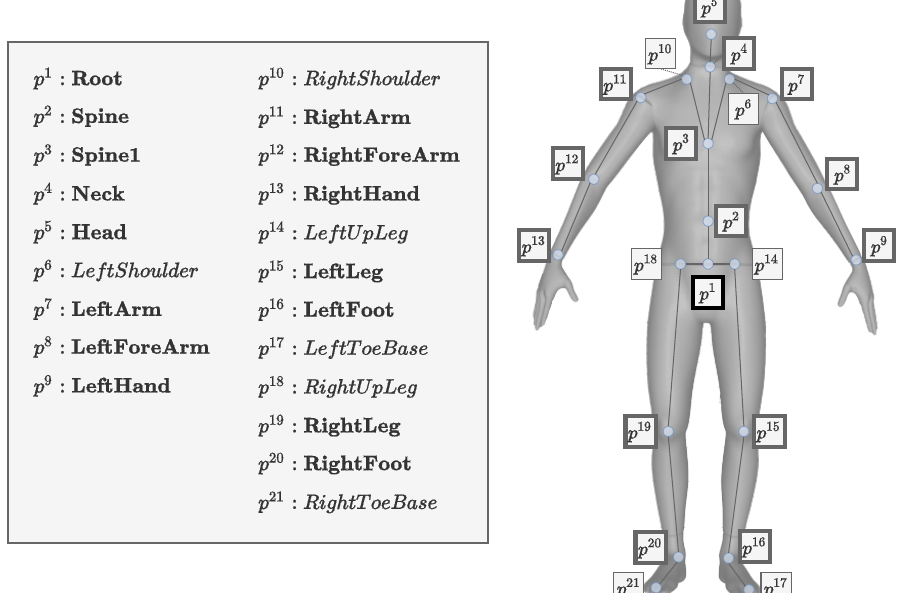
Figure 4. Skeleton structure: the skeleton for our study had 21 joints ( p 1 to p 21 ). The 15 joints that were used to evaluate the errors in the experiments are highlighted in bold and thickly lined boxes. The joint list for evaluating the errors was as follows: Hip, Spine, Spine1, Neck, Head, LeftArm, LeftForeArm, LeftHand, RightArm, RightForeArm, RightHand, LeftLeg, LeftFoot, RightLeg, and